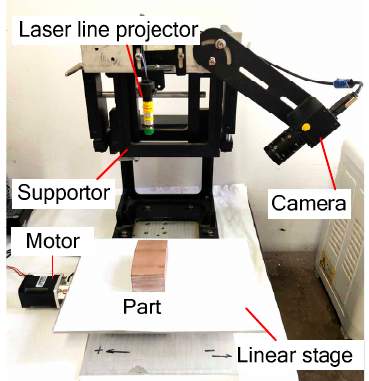
Figure 8. Configuration of the laser line scanning system.